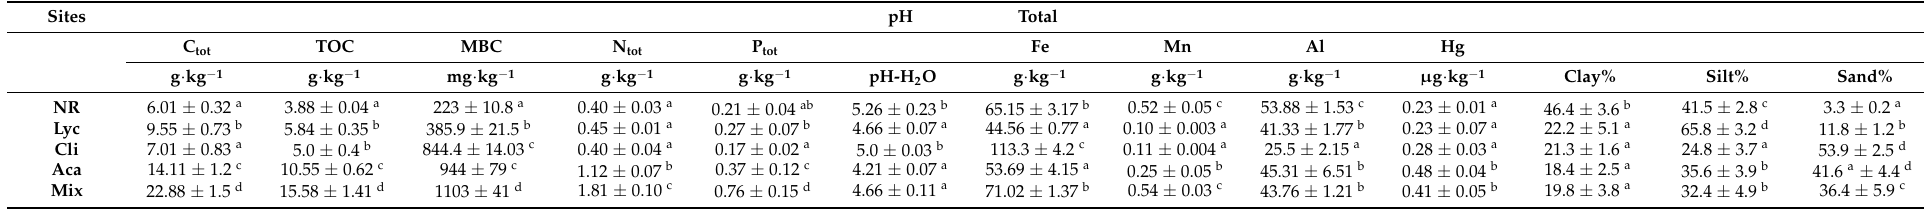
Table 1. Ctot, Ntot, Ptot: Total C, N and P; TOC: Total Organic Carbon; MBC: Microbial biomass carbon; Total Fe, Al, Hg: Total Iron, Aluminum and Mercury content, ( n = 5, mean ± SD). For each parameter, values followed by different letters (a,b,c,d) differ significantly with p < 0.05 with Tukey HSD test. Sites pH Total C tot TOC